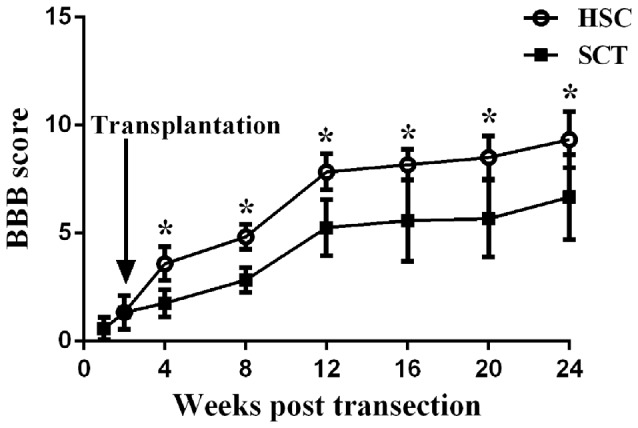
HSCs transplantation improved the neural behavior in rats subjected to SCT. BBB score of the sham group was 21. There was a significant decrease of BBB score at week 1–24 after operation in SCT and HSC group (n = 15/group). HSC transplantation group displayed a significantly improved scores compared with SCT group beginning at week 2–22 after transplantation. Three independent experiments were performed and the data are presented as the mean ± SD (n = 15). Student’s t test was used to analyze the data. *P < 0.05 vs. SCT. Arrow indicates the HSC transplantation time.